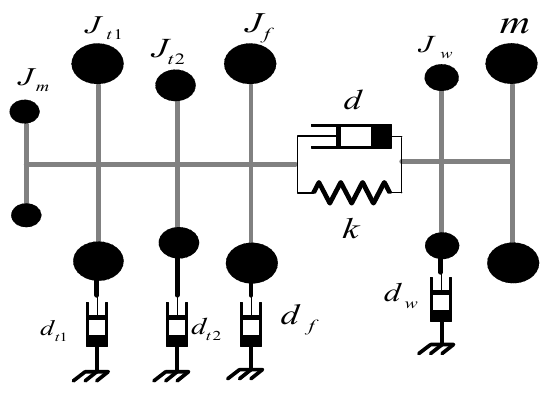
Figure 3. Six degrees of the freedom model of electric vehicle (EV) drivetrain. Table 1. Symbols and subscripts of electric vehicle (EV) drivetrain model cite.